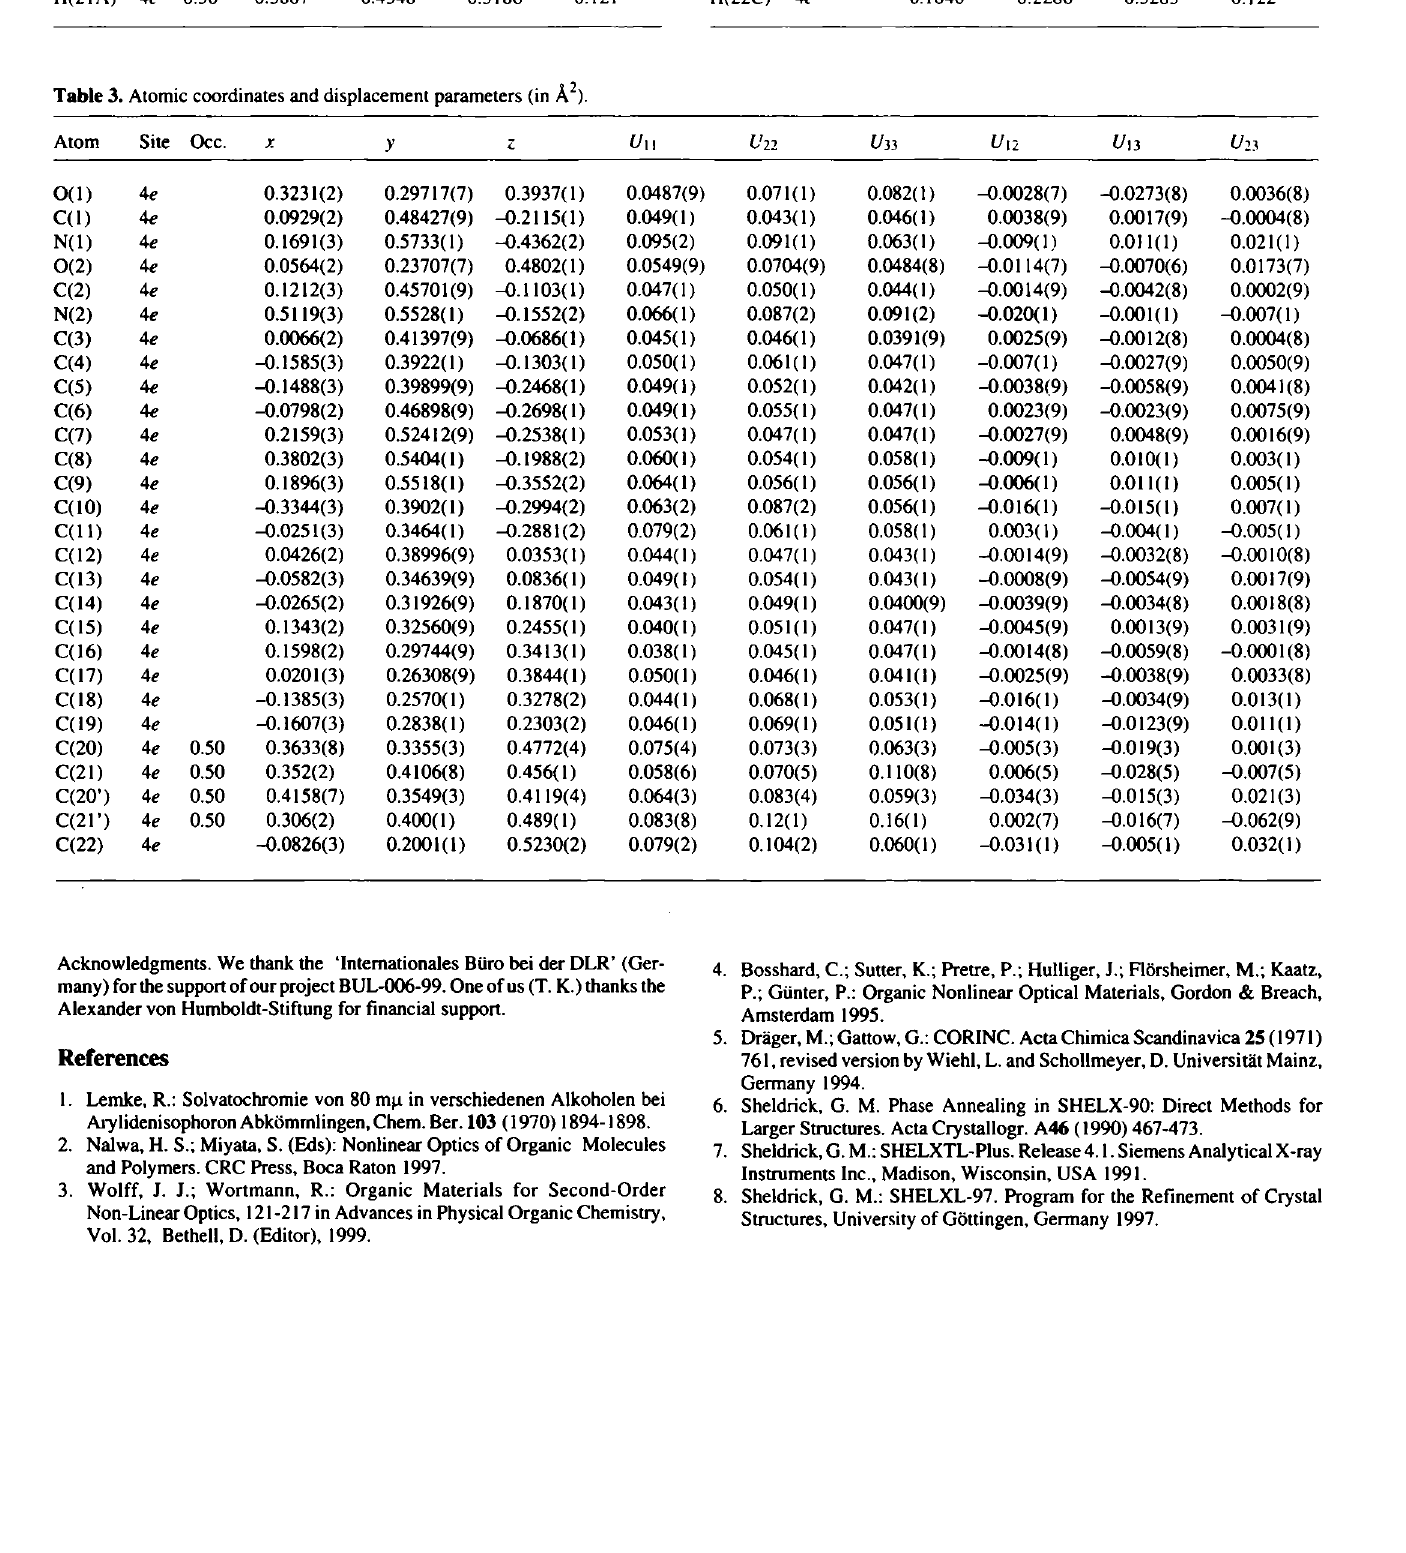
Table 3. Atomic coordinates and displacement parameters (in A 2